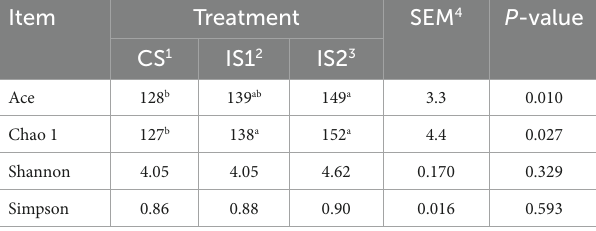
TABLE 4 Influences of different stirring times on Alpha diversity indices of the bacterial population.